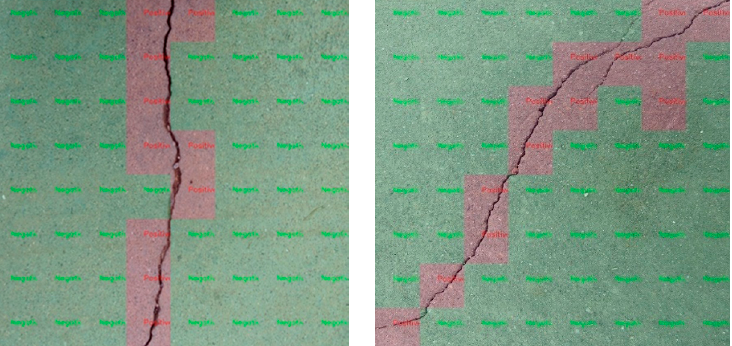
Figure 8. Image test.